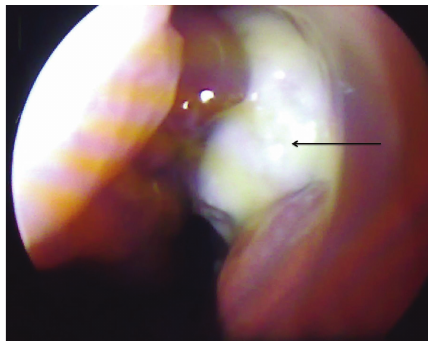
Figure 2: Diagnostic nasal endoscopy showing thick purulent discharge in the middle meatus.